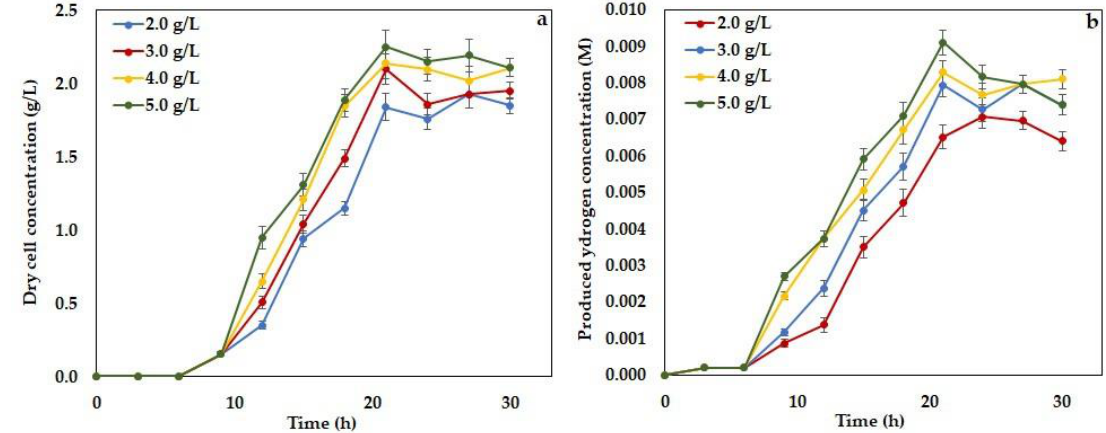
Figure 8. Experimental time histories of dry cell concentration ( a ) and produced hydrogen concentration ( b ) with initial 30% (v/v) H 2 in reactor headspace at different substrate concentration.